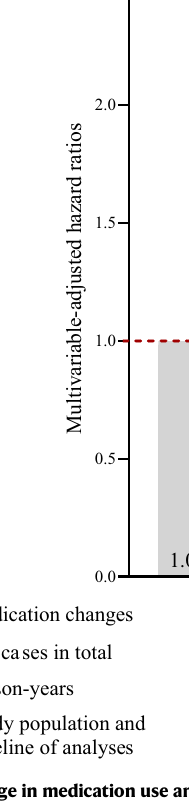
changes. Error bars indicate 95% con fi dence intervals. Multivariable-adjusted hazard ratios were strati fi ed by age (in months), sex/cohort (women, men; in the pooled analyses only), and calendar year of the survey cycle (each 2-year interval); and adjusted for race/ethnicity (white, black, other, unknown), BMI